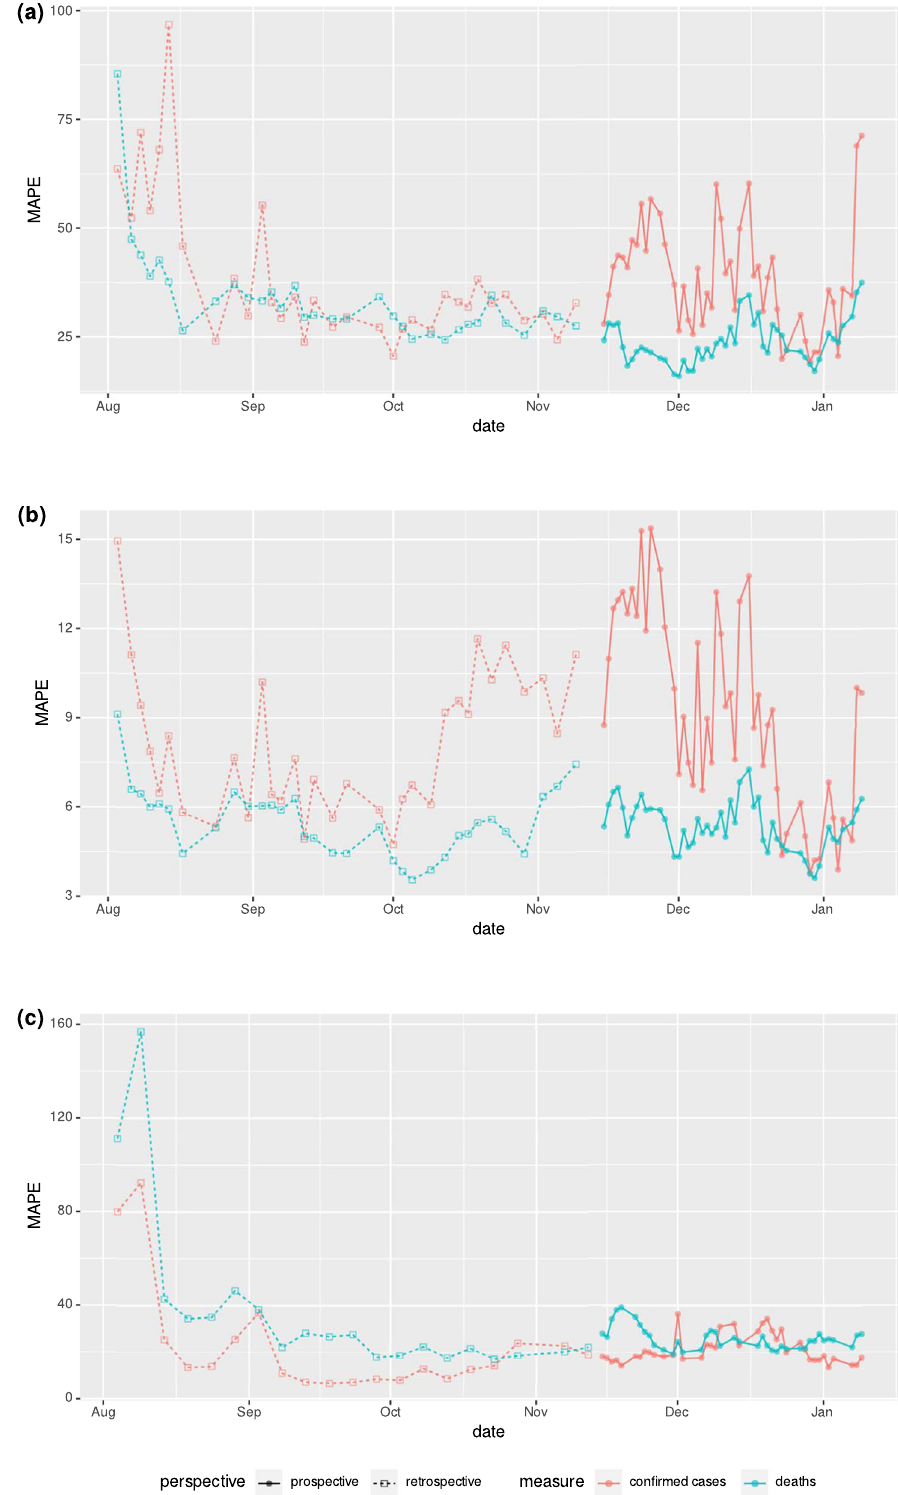
Fig. 5 Retrospective and prospective 28-day MAPE over time. Performance over time is shown for the ( a ) state-level US models using 4-week incidental predictions ( b ) state-level US models using cumulative predictions ( c ) prefecture-level Japan model using cumulative predictions. Japan ’ s 4-week incidental deaths and cases were too low to meaningfully report. Metrics shown are the “ mean absolute percentage error ” for predicted deaths and predicted con fi rmed cases compared to ground truth. Retrospective performance during model development periods for con fi rmed cases (orange) and deaths (light blue) are shown alongside performance reported during the prospective study for cases (dark blue) and deaths